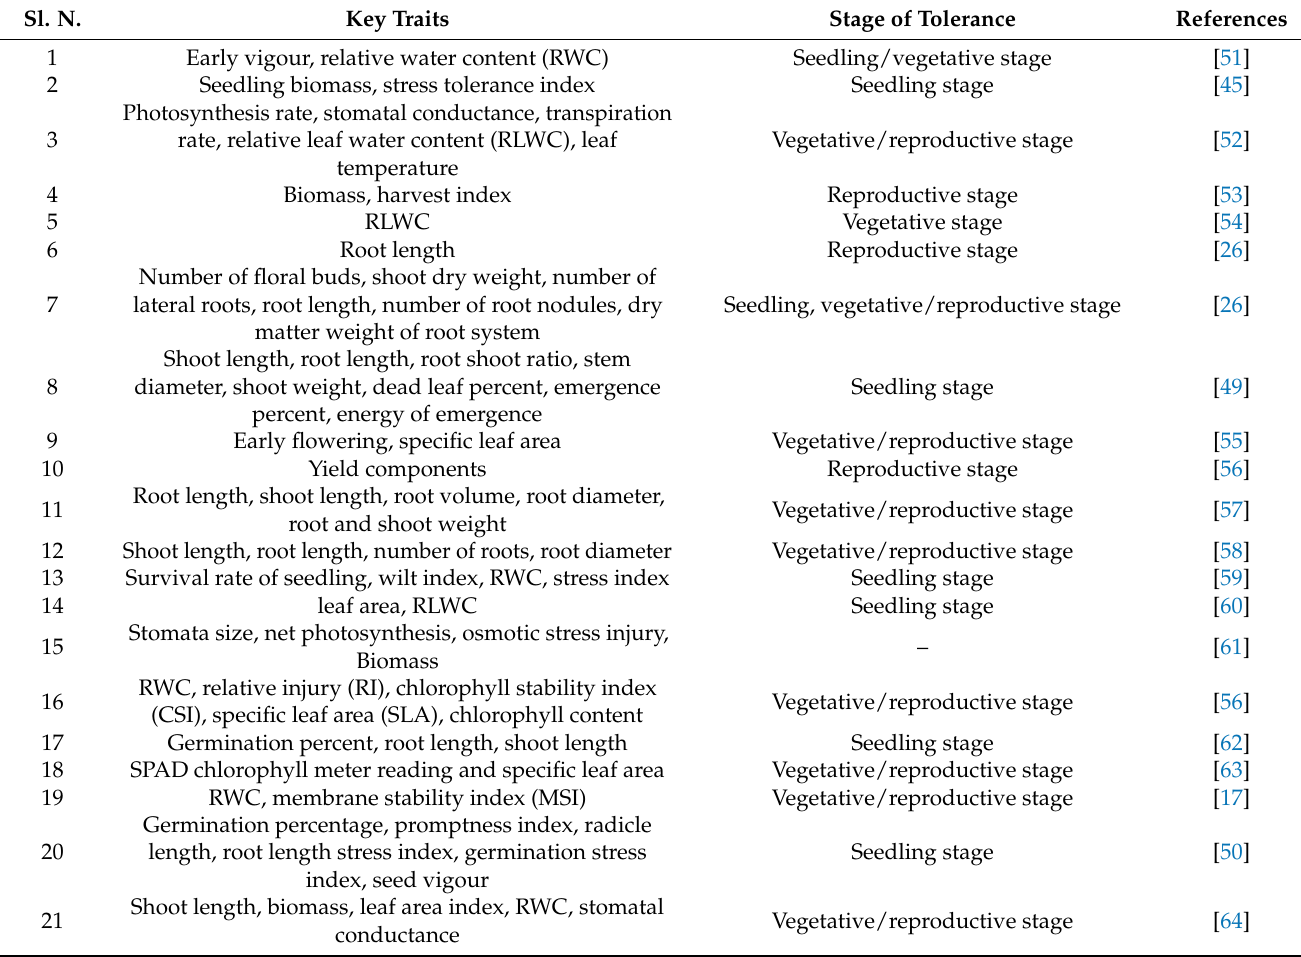
Table 1. Key morpho-physiological traits for improving drought tolerance in mungbean. Sl. N. Key Traits Stage of